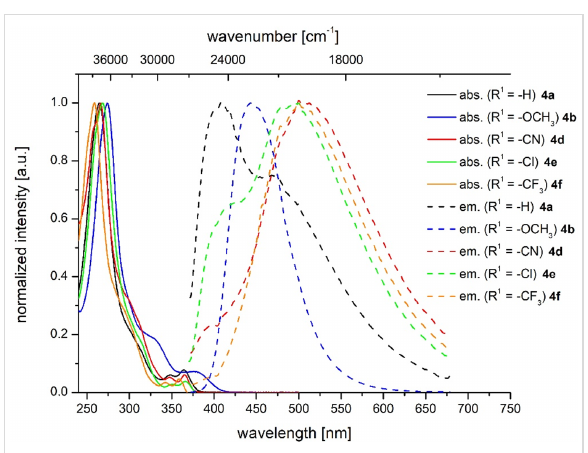
Figure 6: Absorption and emission properties of selected imides 4 measured in CH 2 Cl 2 UVASOL ® at 293 K with λ exc = 360 nm.